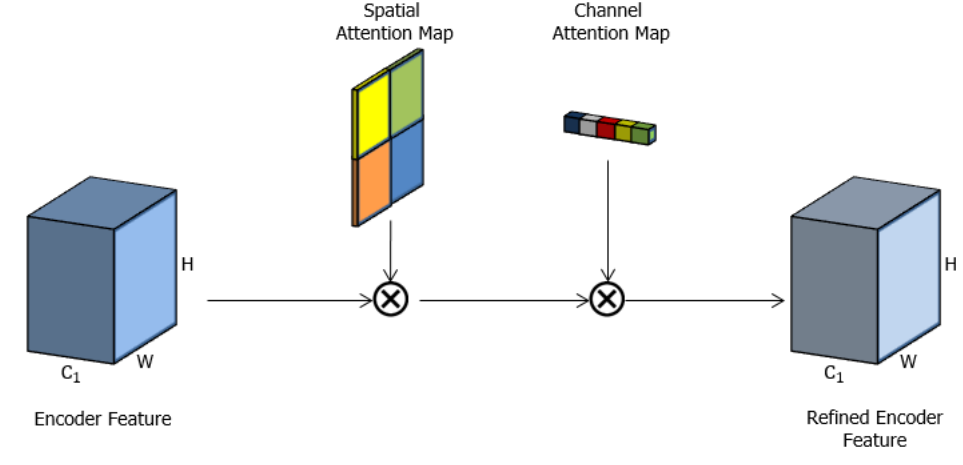
Figure 4. Process of refining the input